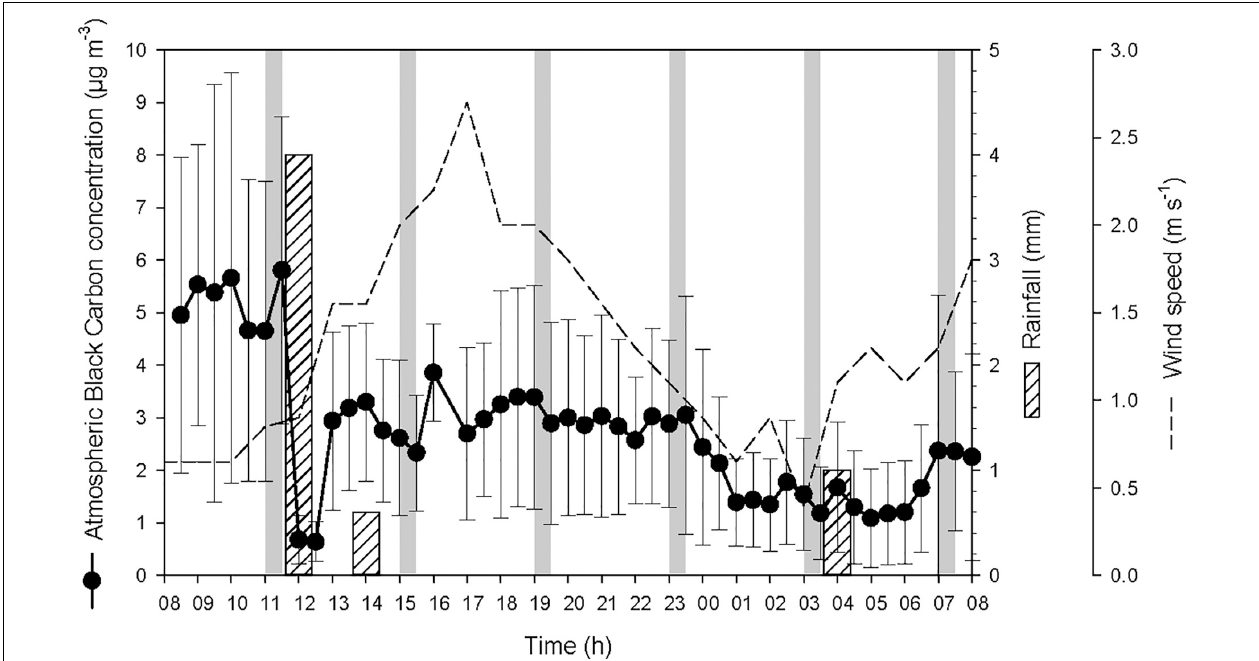
FIGURE 2 | Atmospheric black carbon concentration (average for every 30 min ± SD) at the sampling station, and precipitation and wind speed measured in Haiphong City during the 24-h cycle. The vertical gray bars represent the six sampling